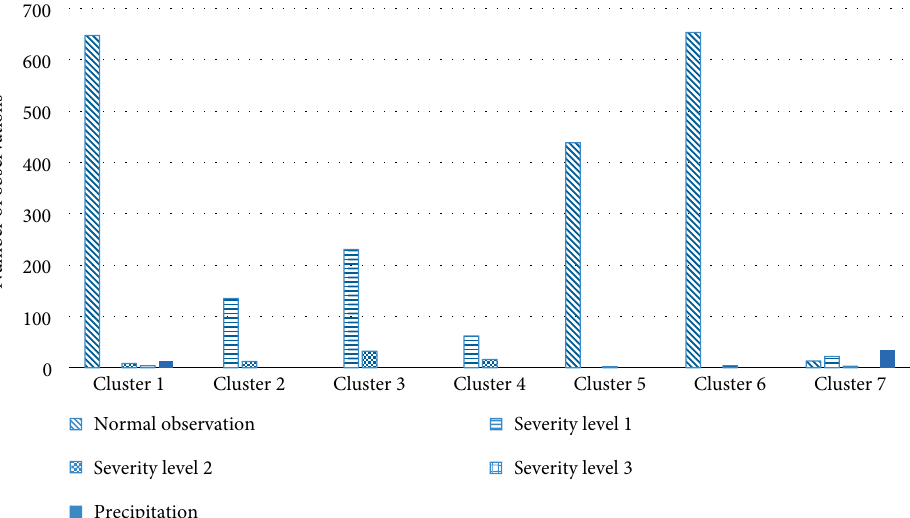
Figure 9: Observations with different level of severity and precipitation in the clusters identified by the K-prototype